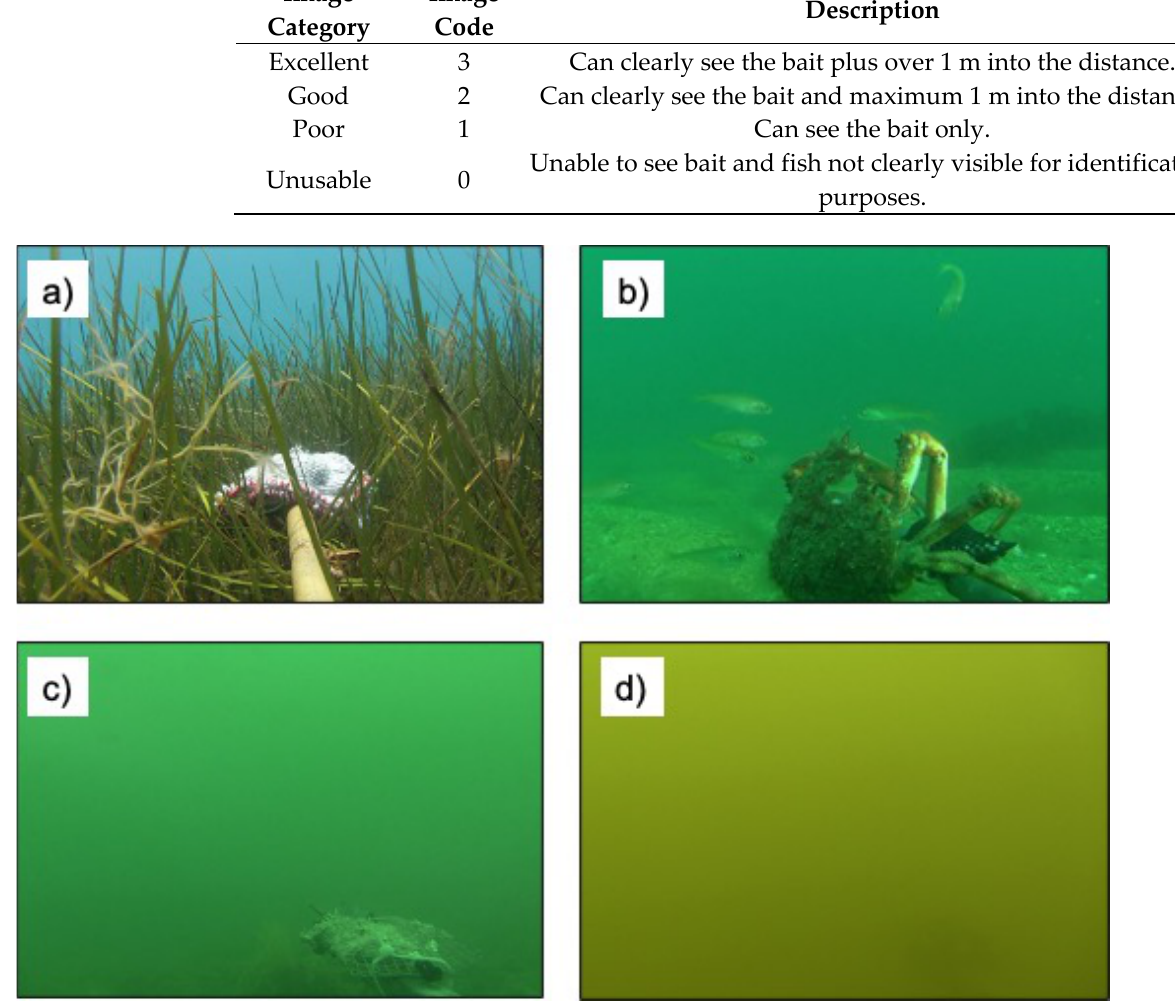
Figure 2. Examples of the image quality criteria used in developing the BRUV database: ( a ) excellent, ( b ) good, ( c ) poor and ( d )